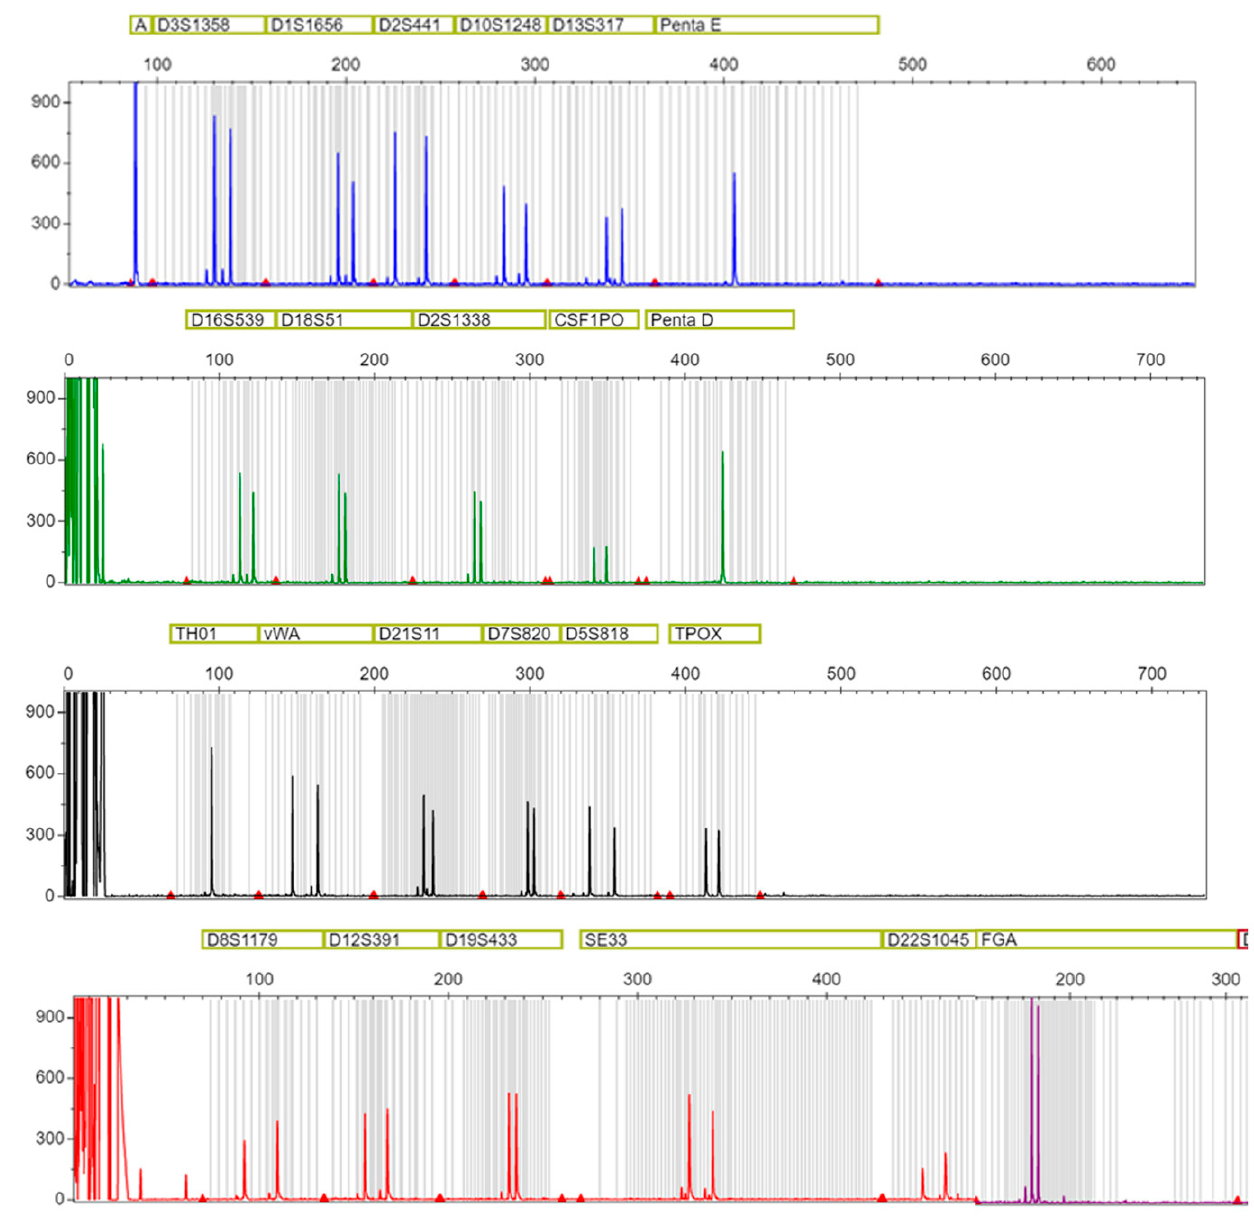
Figure 4. Representative STR profile obtained from the samples. The Y-axis represents relative fluorescent units (RFUs); the X-axis represents fragment lengths in base pairs. On the top, the STR is analyzed. The peaks represent fragments of the respective STR locus. Two peaks represent a heterozygous, one peak represent a homozygous. A represents Amelogenin, which determines the sex. In this case, the donor carried the X,X chromosomes, thus, the sample came from a female. Please note that FGA has a different color as it is identified by a different component; however, for representation purposes, it has been combined with the last row of the profile. Allele calls were removed for privacy.